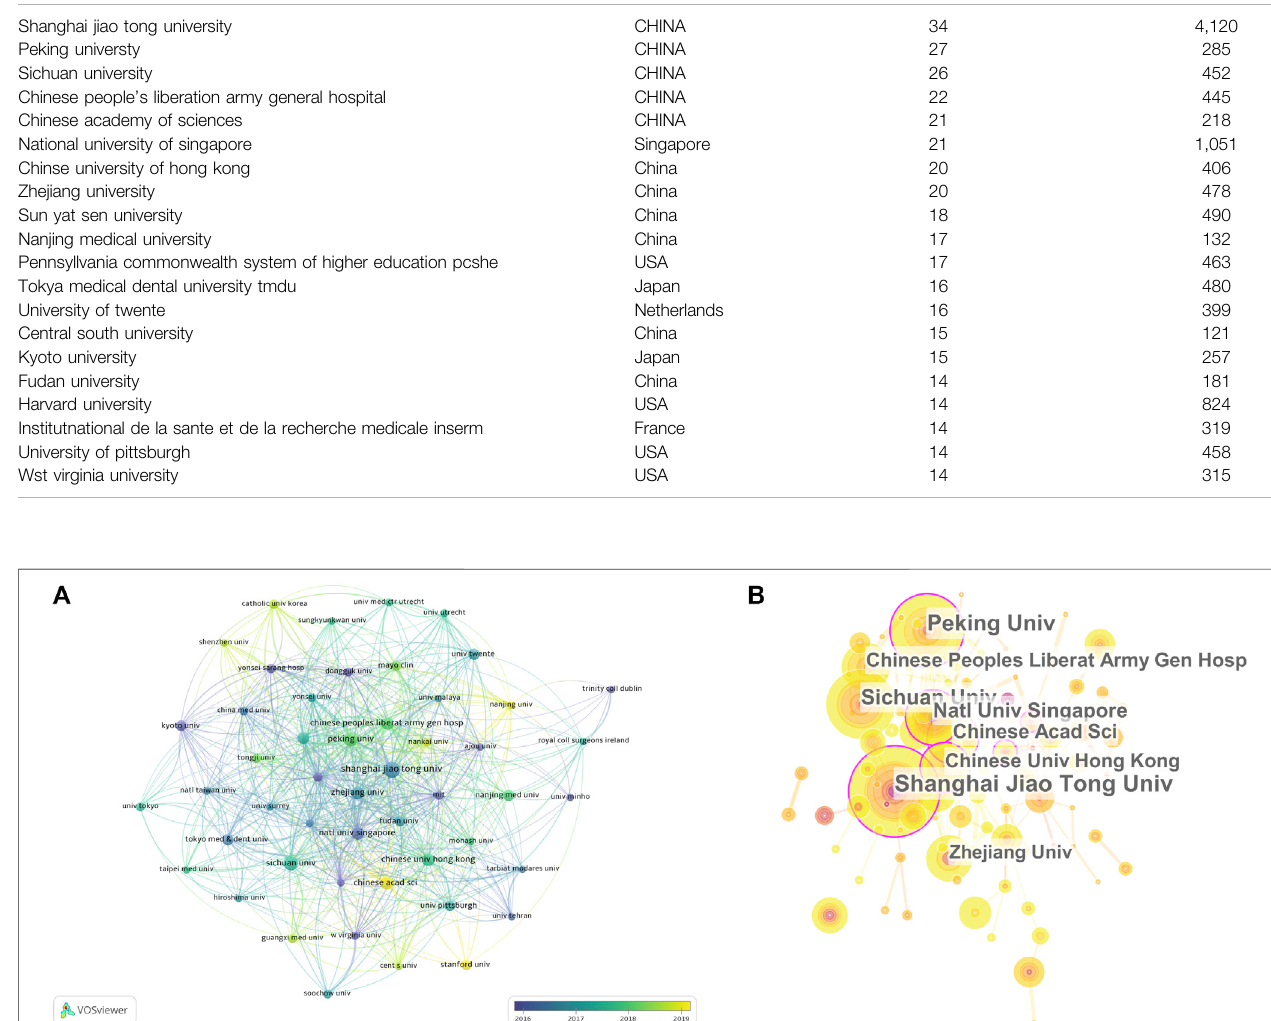
Frontiers in Pharmacology |